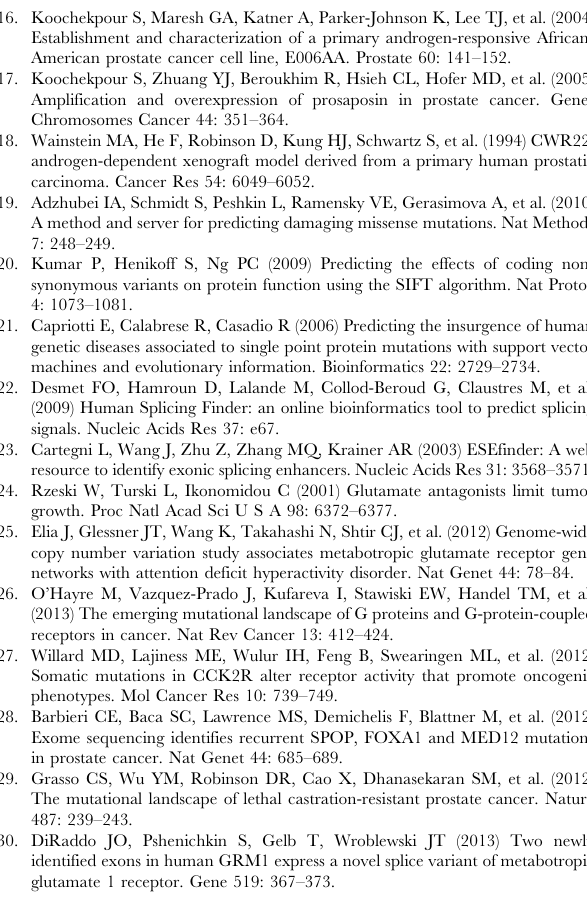
Table S2 Details of somatic mutations in GRM1 gene identified in whole exome or transcriptome sequencing studies of prostate cancer cell lines and